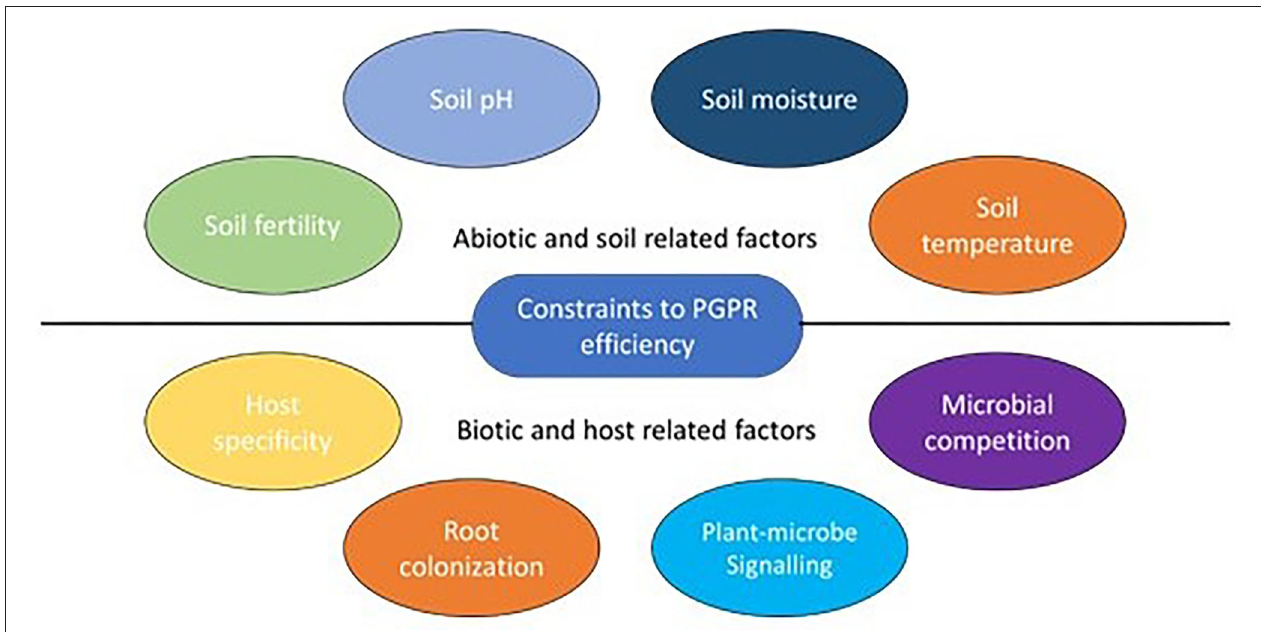
FIGURE 2 | Constraints to PGPR efficiency and